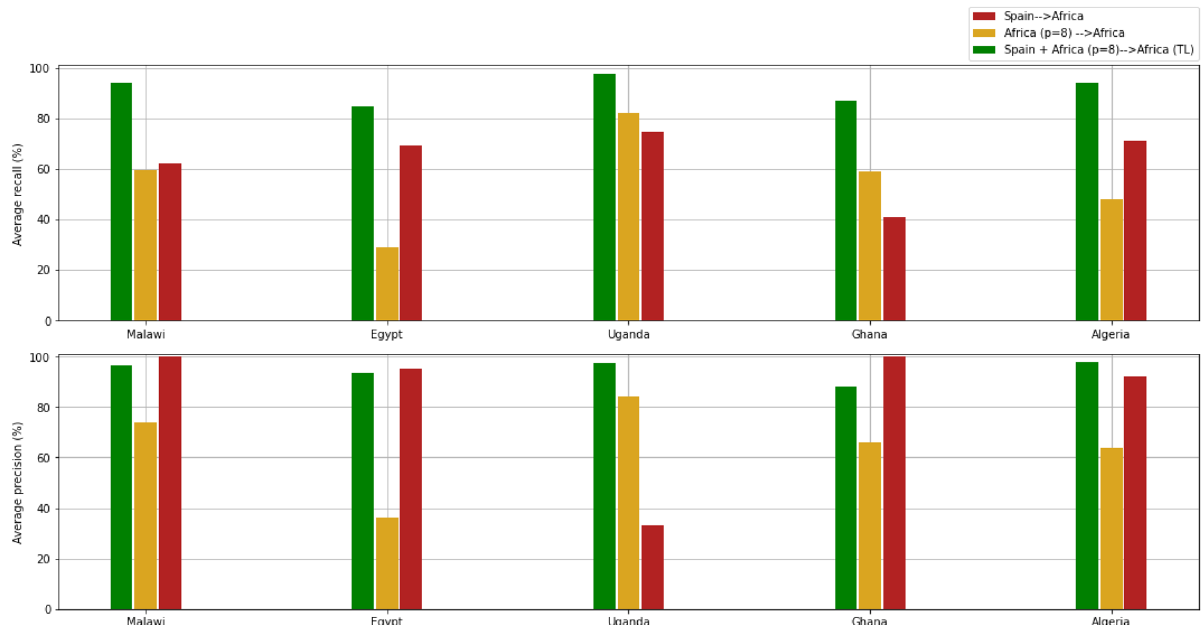
Figure 6. A summary of the performance achieved when only 8 patients from Egypt, Uganda, Ghana, Algeria and Malawi are used in terms of recall and accuracy. First, the model is directly trained with the African samples (yellow). Second, the model is trained using only the large Spanish dataset (red). Finally, the pre-trained Spanish model is fine-tuned with the new African samples